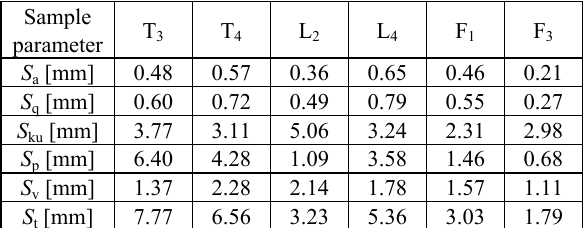
Table 2. Statistical parameters describing surface roughness for the Krosno Sandstones of Mucharz